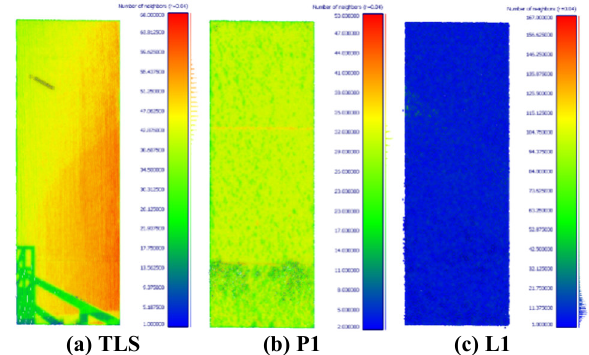
Figure 7. Density analyses of a west façade section. The color scale on the right of each image is proportional to the number of neighbors, while the image represents the density visualization..